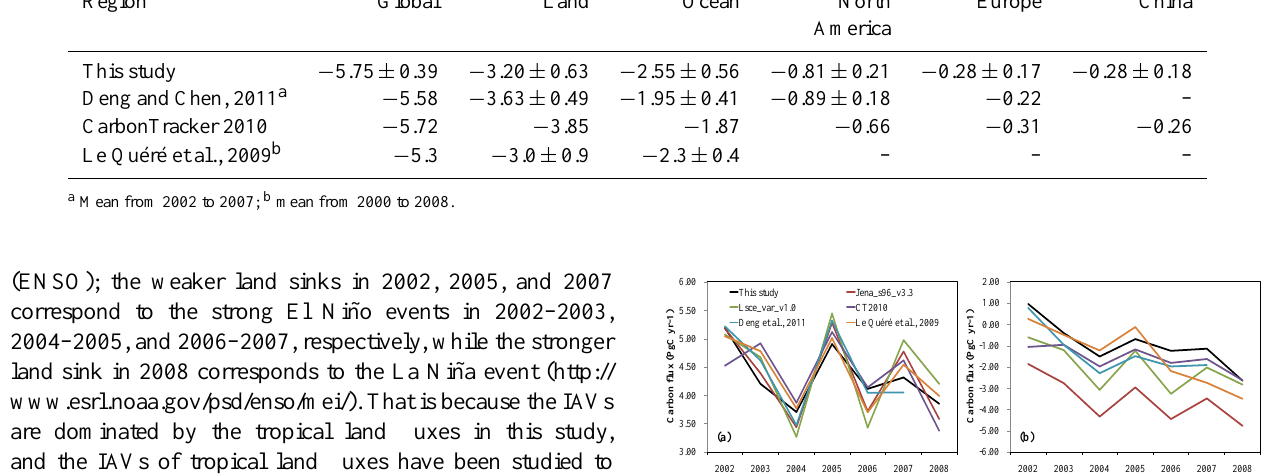
Table 2. Comparison of the inverted carbon sinks in this study with previous studies during 2002–2008 (PgCyr − 1 ). Region Global Land Ocean North